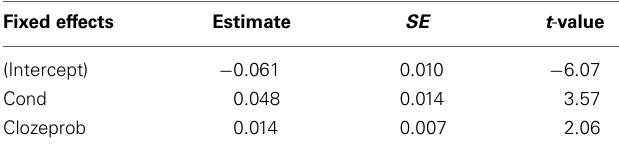
Table 5 | Fixed effects for trimmed Gamma model.